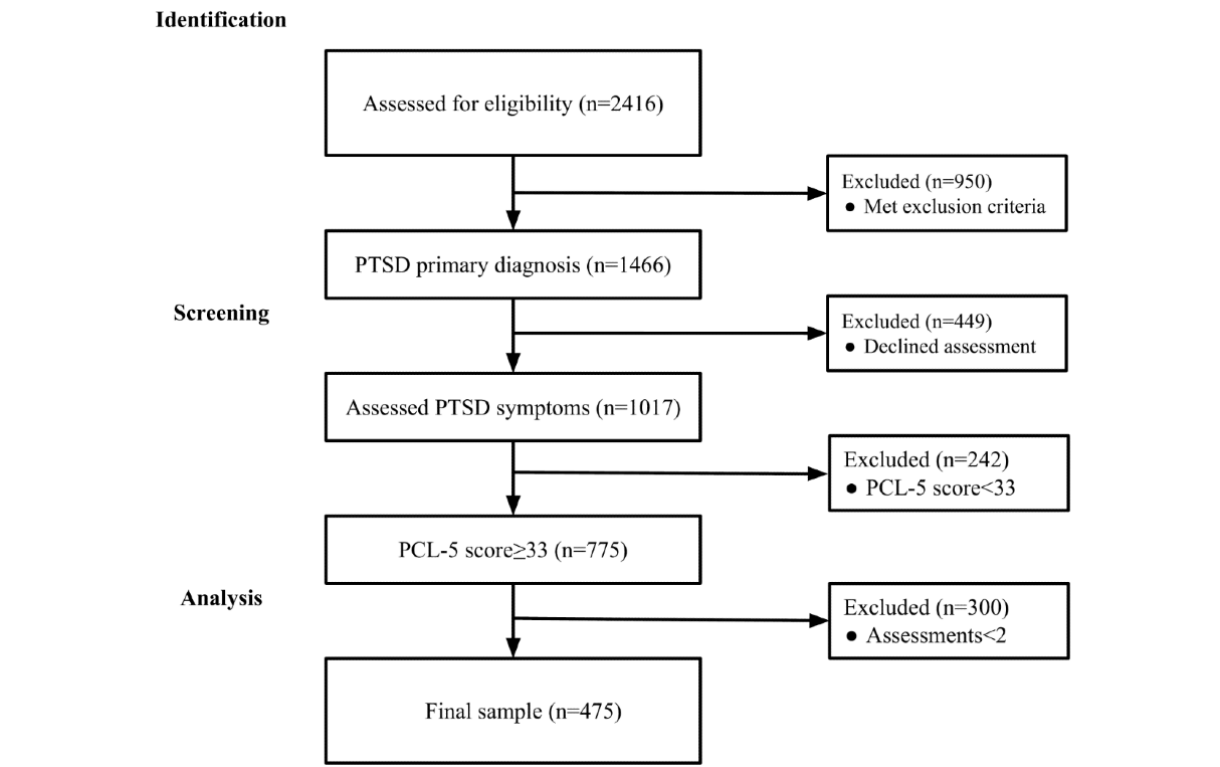
Figure 1. Flowchart of patient selection for the study. PCL-5: Posttraumatic Stress Disorder Checklist for the Diagnostic and Statistical Manual of Mental Disorders-5; PTSD: posttraumatic stress